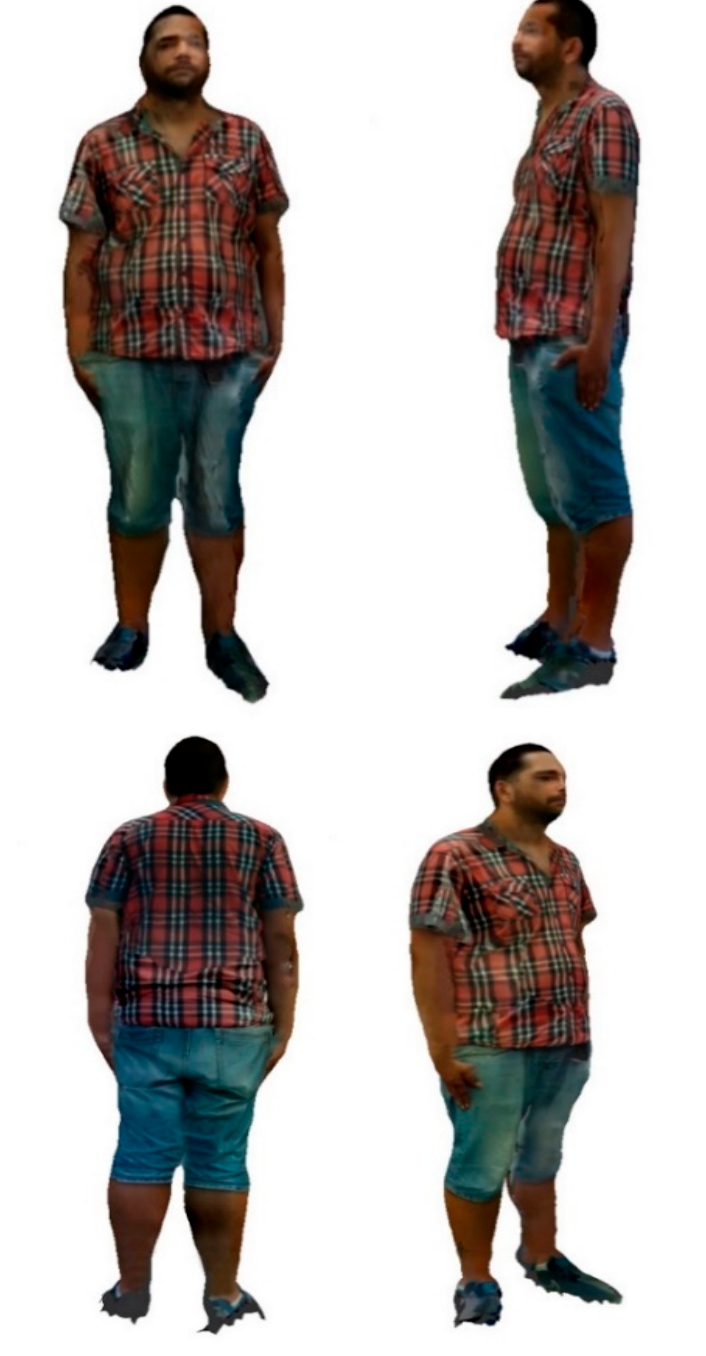
Figure 4. Different views of the same textured body